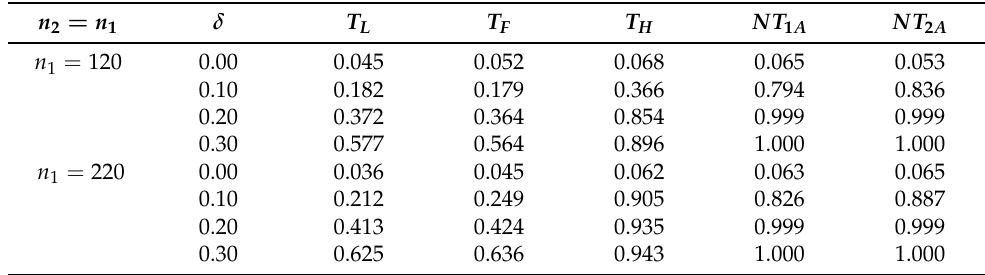
Table 5. Size and power of five methods in Setting 5 (difference averaged in total vector µ 2 = µ 1 + δ 1 40 ).